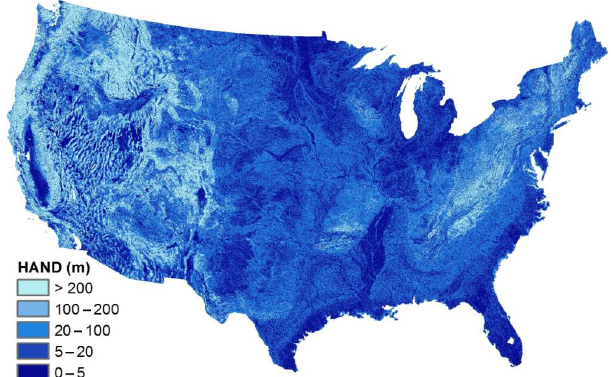
Figure 11. The HAND map of the